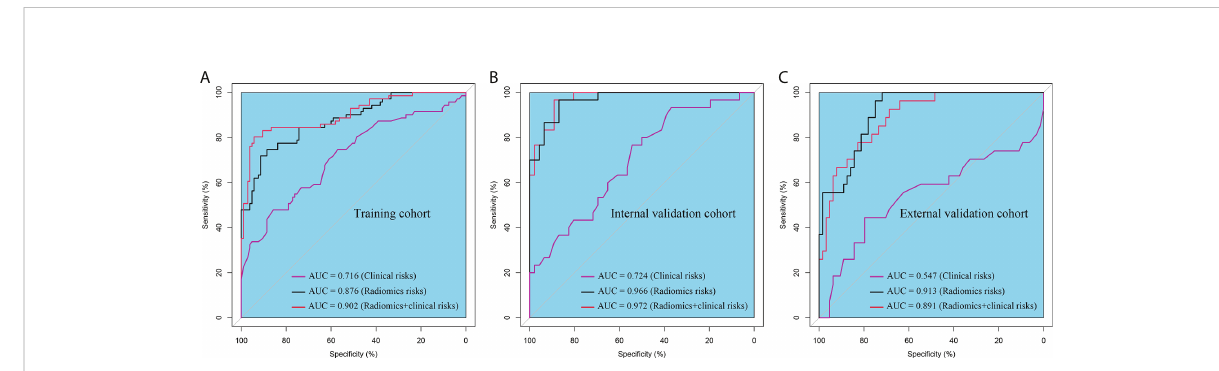
FIGURE 5 The ROC curves of the clinical risk, radiomic signature and radiomic nomogram (radiomic signature + clinical risk) in the (A) training cohort, (B) internal validation cohort, and (C) external validation cohort.